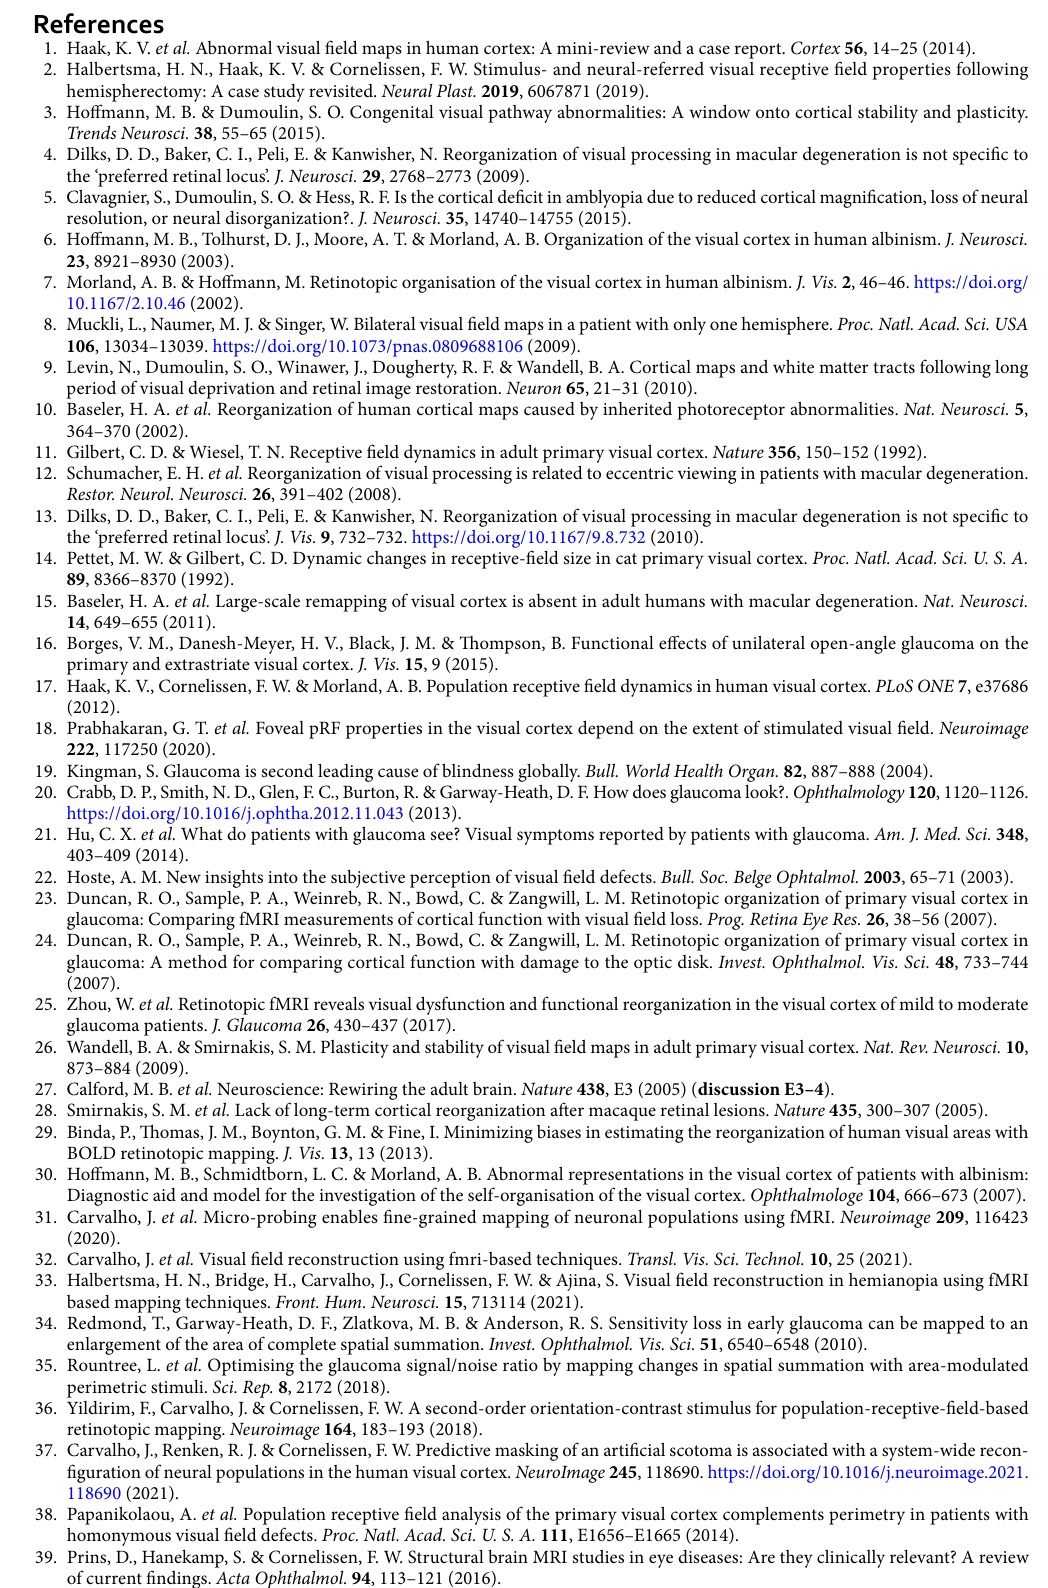
figuration of neural populations in the human visual cortex. NeuroImage 245 , 118690. https:// doi. org/ 10. 1016/j. neuro image. 2021. 118690